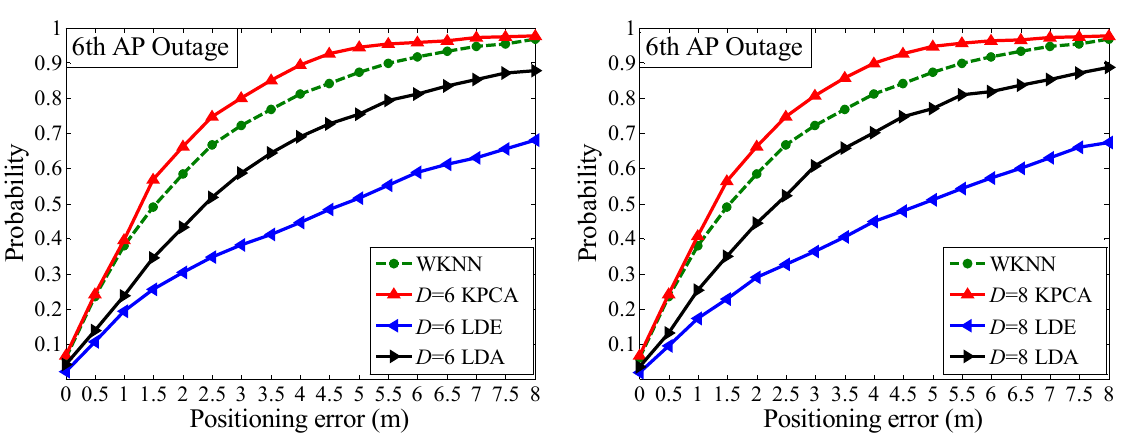
Figure 13. Positioning accuracies comparison in the cases of 12th AP outage and both 4th, 24th APs outage